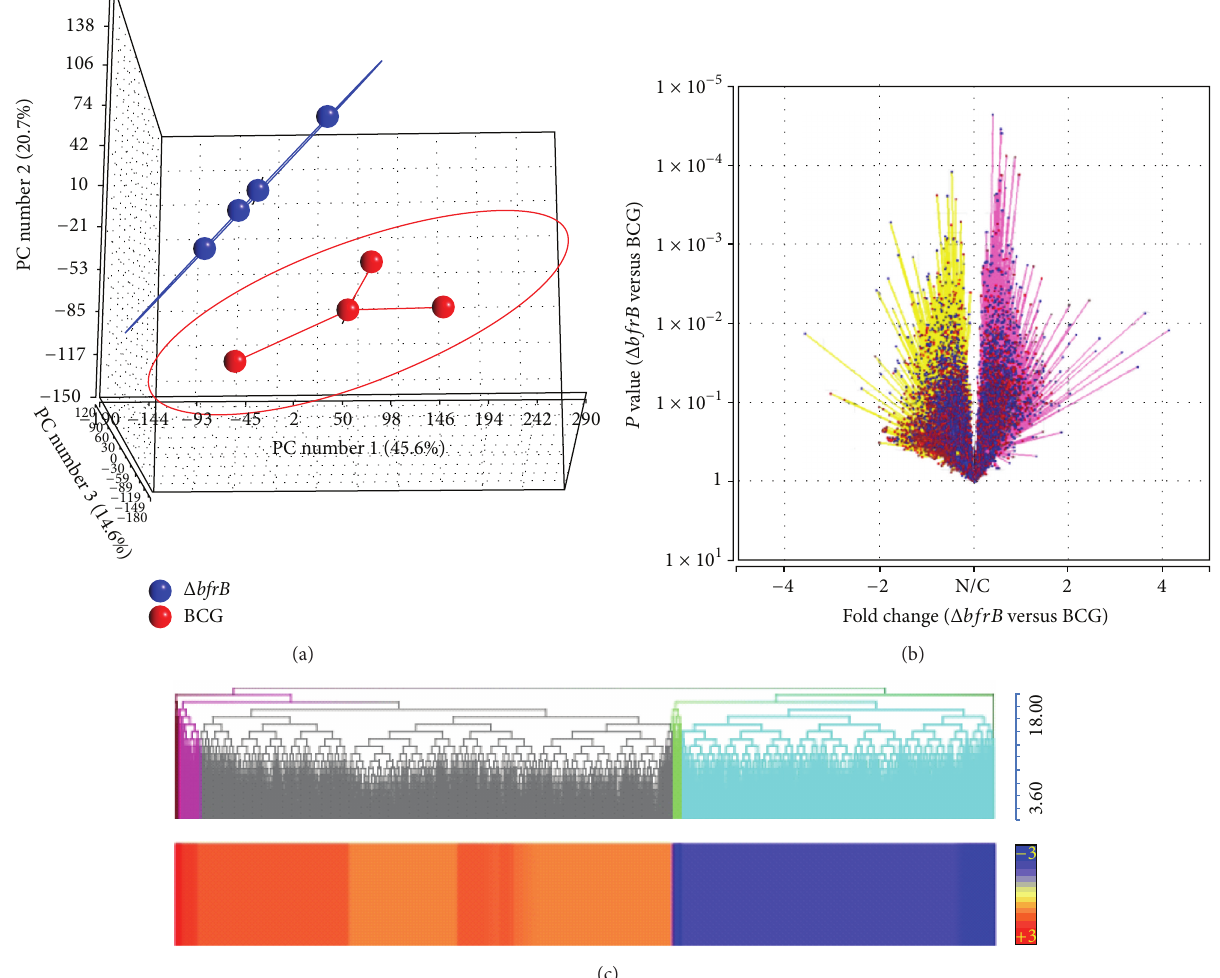
Figure 3: Genome-wide gene expression profiling of vaccinated and Mtb-infected mice lungs. (a) Principal component analysis of lung transcriptome data from Δ bfrB (blue) or BCG (red) vaccinated, Mtb-infected mice. The eclipse around each group denotes the standard deviation of the datasets. (b) Volcano plot of lung global gene expression showing the 𝑃 value significance ( 𝑦 -axis; log scale) and fold change ( 𝑥 -axis). Upregulated genes are shaded in purple and downregulated genes are in yellow. N/C denotes no change. Each spot (blue) in the plot corresponds to a gene. (c) Intensity plot and dendrogram of significantly differentially expressed genes in the Δ bfrB vaccinated, compared to BCG vaccinated, Mtb-infected mice lungs. Upregulated genes are in red and downregulated genes are in blue. The color scale bar ranges from +3 (red) to − 3